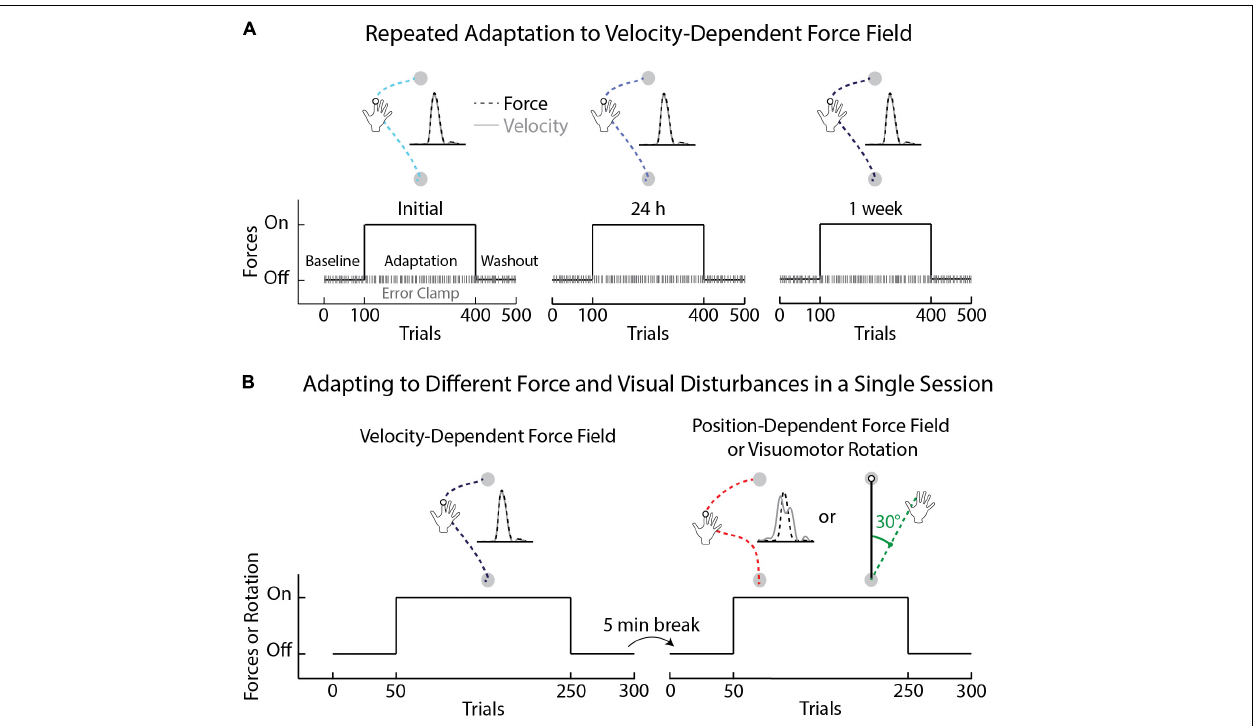
FIGURE 1 | Schematic of experimental protocols. (A) Task protocol and time course of Experiment 1 . Participants began the first session (Initial) by performing unloaded reaching movements (Baseline phase), followed by movements with velocity-dependent forces (Adaptation phase), followed by unloaded reaching movements (Washout phase). Error-clamp trials were interleaved throughout the experiment (20% of trials in each phase). The same protocol was repeated the following day (24 h) and again 1 week after the 24-h session (1 week). (B) Task protocols for Experiments 2a and 2b . In Experiment 2a participants adapted to velocity- and position-dependent force fields. The magnitude of the position-dependent force field was identical across trials and independent from the velocity of movement. Participants in Experiment 2b adapted to a velocity-dependent force field and a 30 ◦ visuomotor rotation. The order of the tasks was counterbalanced across participants. The direction of the force fields and visuomotor rotation was flipped for left-handed participants.